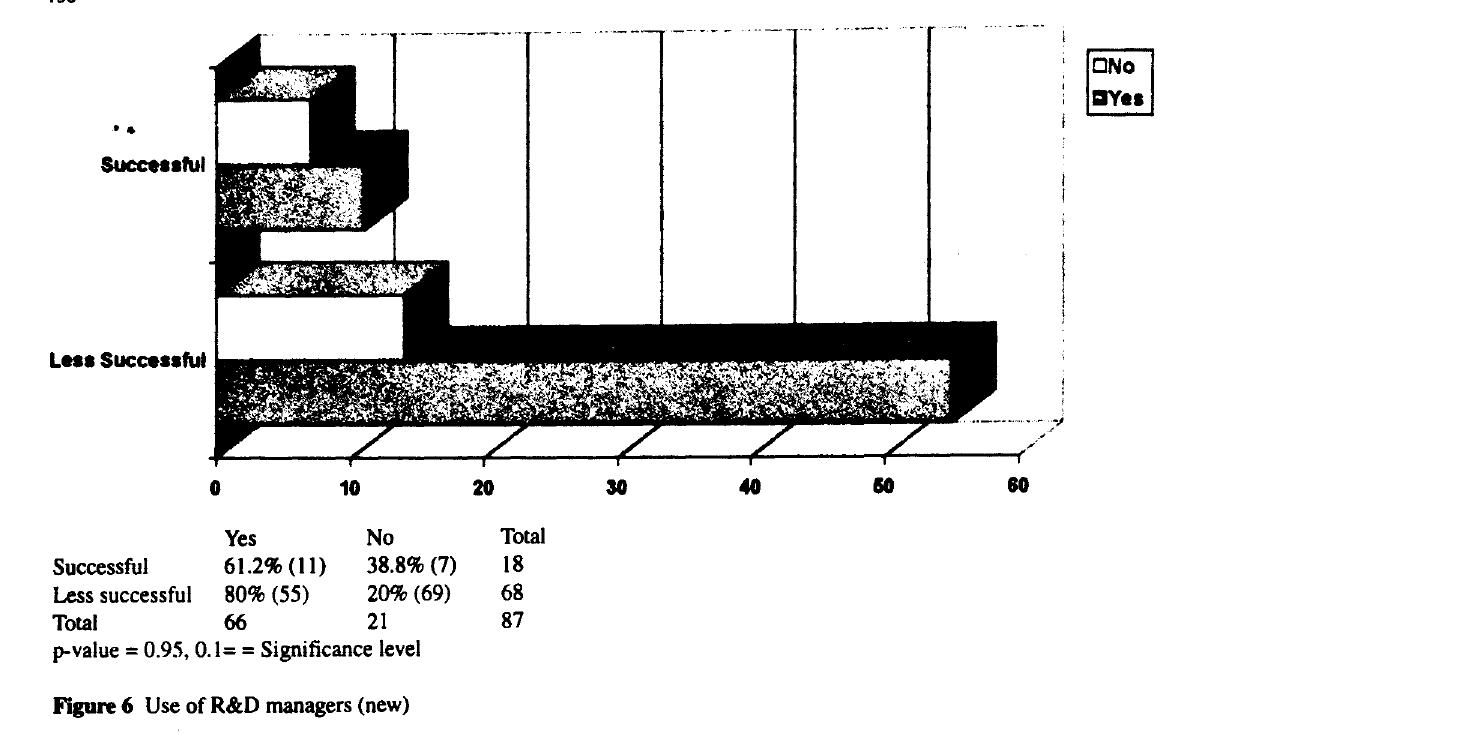
Figure 6 Use of R&D managers (new) needs to be placed on market research and research and devel opment. More collaboration with external agencies is also needed. A balance needs to be created between old and new innovation activity. There are several factors that influence success in respect of product